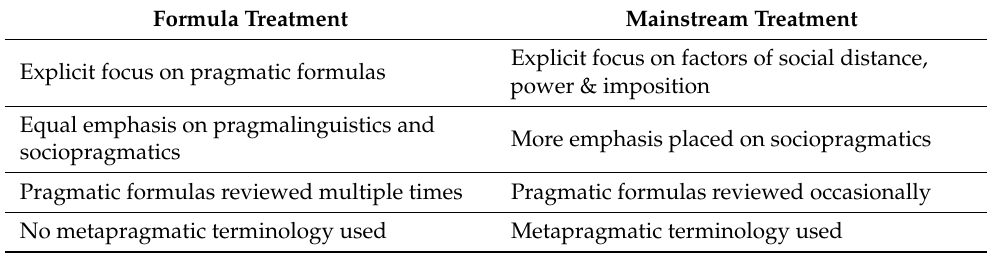
Table 2. Key characteristics of the two pedagogical treatment programs in Zavialova